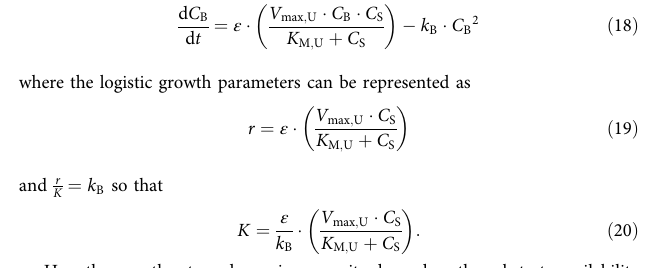
Fig. 12. Data availability . Source code and data are available from the corresponding authors on request. Details about the data and the data sources are reported in Supplementary Tables 2 and